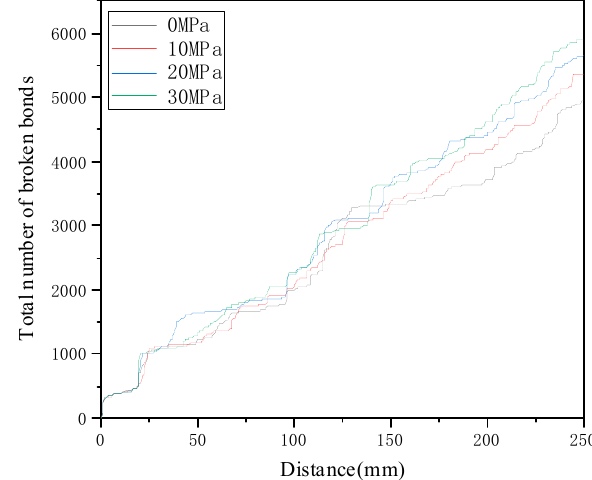
Figure 13. Cumulative number of broken bonds.